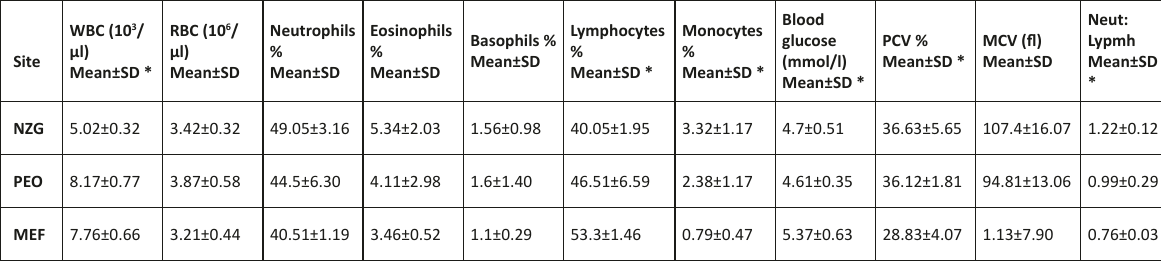
Table 1. Means ± SDs of Haematological parameters of the three study groups. (* Indicates significantly different